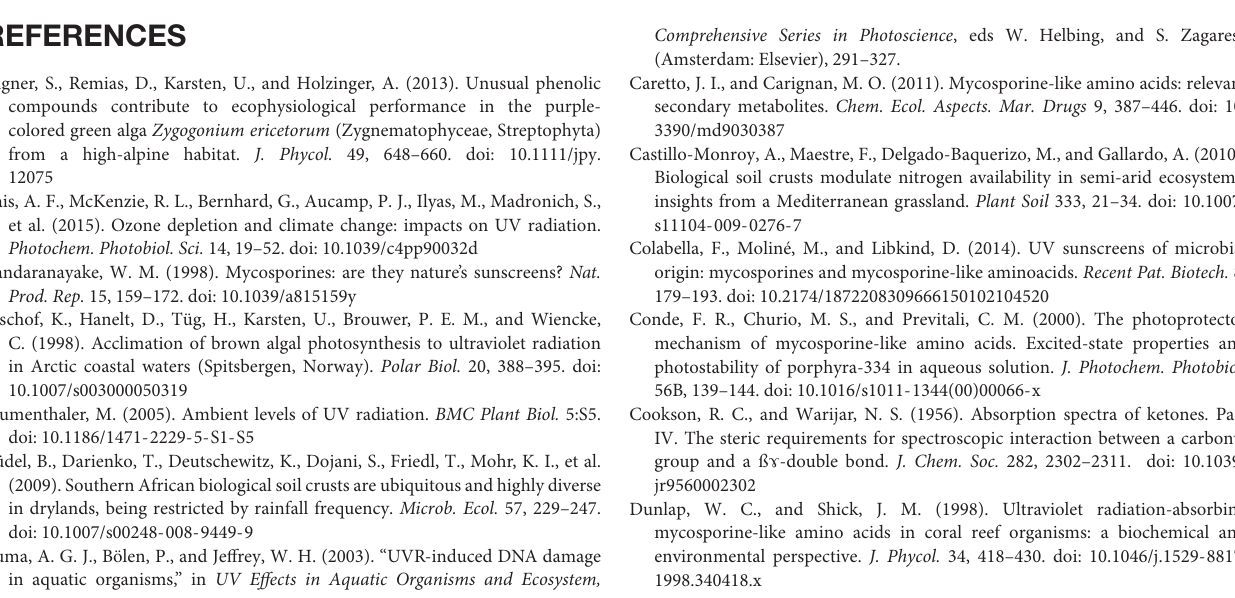
FIGURE S1 | LC-MS spectra of the purified fraction containing both klebsormidin B and gadusol. Separation was carried out on a YMC-Triart C-18 column